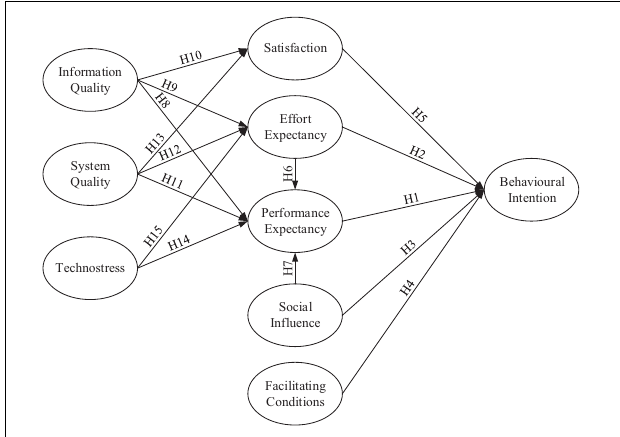
FIGURE 1 | Conceptualized extended UTAUT model for measuring nurses’ use of